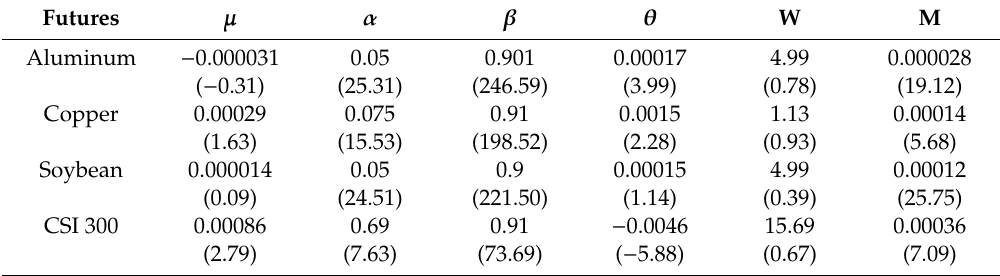
Table 6. Parameter estimates of one side GARCH-MIDAS model with consumer price index (CPI).